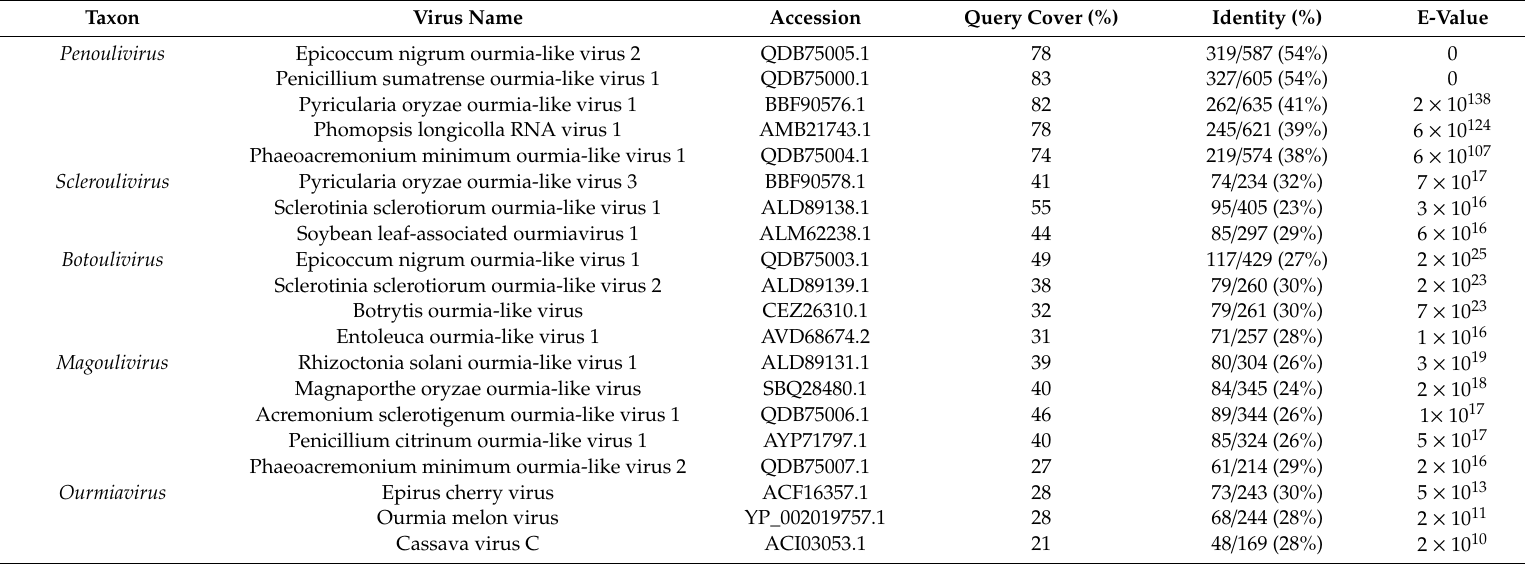
Table 1. Information of BLASTp search results of the RNA-dependent RNA polymerase (RdRp) of Phoma matteucciicola ourmia-like virus